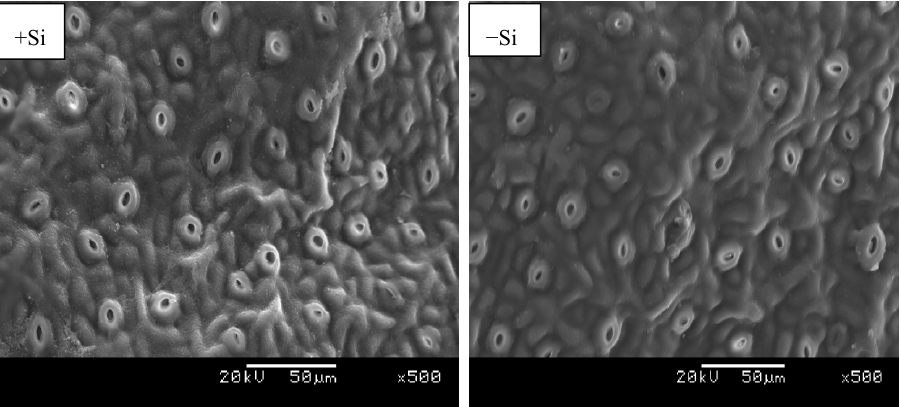
Figure 5. ESEM micrographs of matured citrus leaves subjected to +Si and − Si stomata abaxial leaf surfaces.